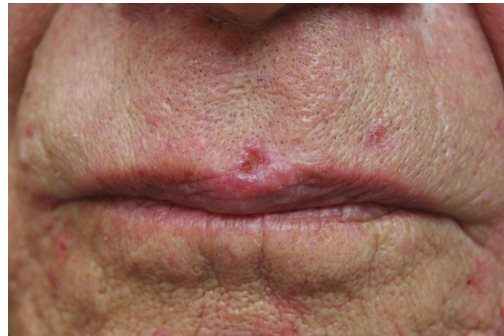
Figure 1: BCCs on the upper mid lip before PDL